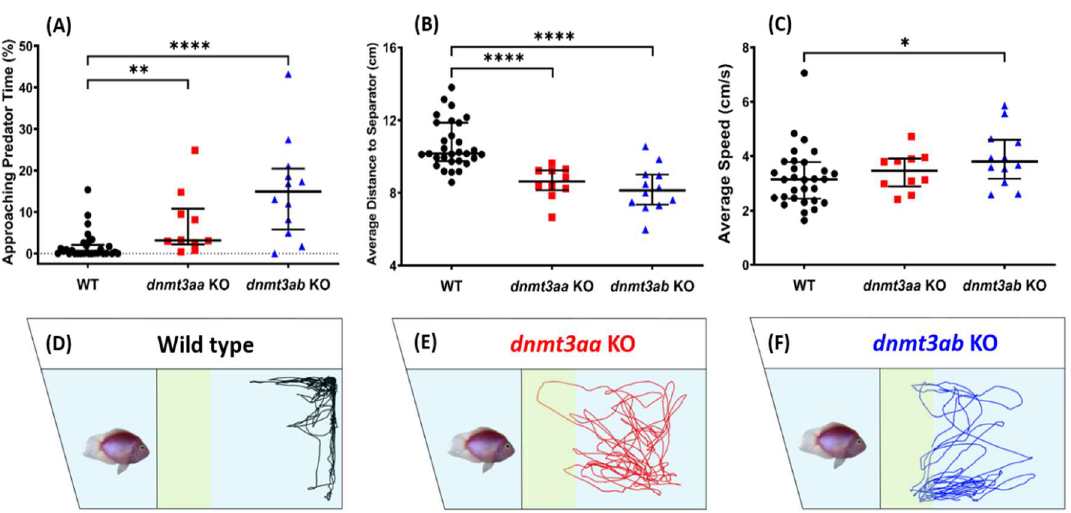
Figure 5. Comparison of predator avoidance behavioral endpoints among the wild-type, dnmt3aa , and dnmt3ab KO mutant fish. ( A ) Approaching predator time percentage, ( B ) average distance to the separator, and ( C ) average speed were analyzed. The data are expressed as the median with interquartile range and analyzed by Mann–Whitney test ( n = 30 for wild type ; n = 10 for dnmt3aa KO fish; n = 12 for dnmt3ab KO fish; * p < 0.05, ** p < 0.01, ****, p < 0.0001). ( D – F ) The locomotion trajectories of a single fish of wild type, dnmt3aa KO, and dnmt3ab KO fish, respectively, during the predator avoidance test. The predator fish were put on the left side of the fish tank and the approaching predator zones were highlighted with yellow color.